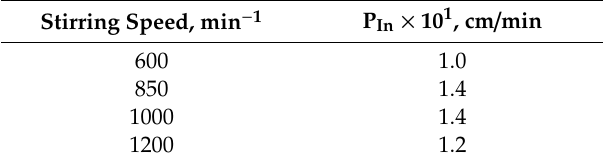
Table 5. Influence of the stirring speed on In(III) permeability. Stirring Speed, min − 1 P In × 10 1 , cm / min 600